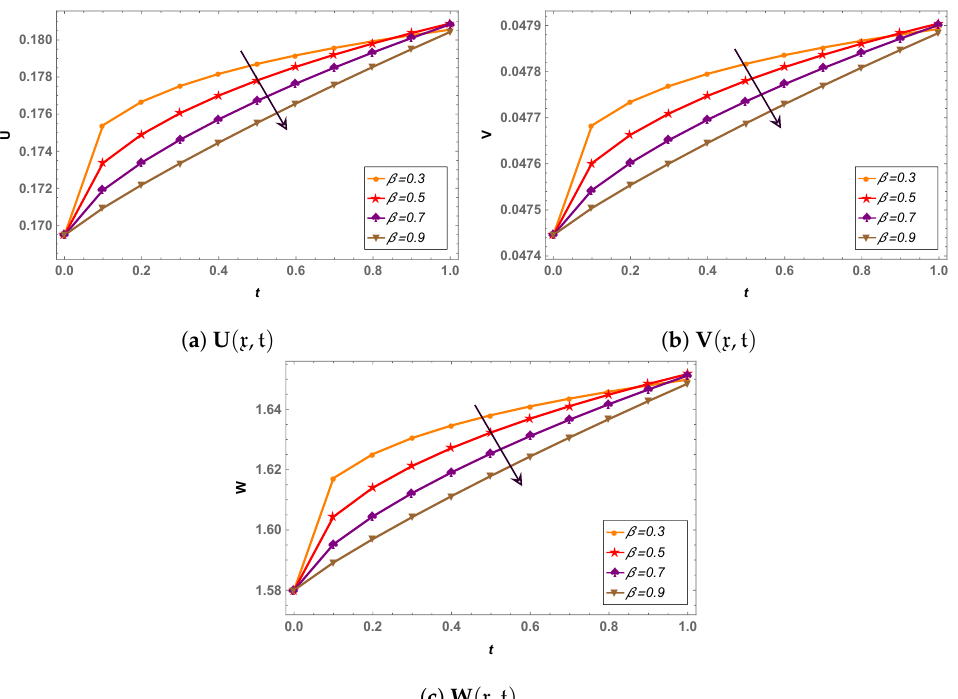
Figure 9. Two-dimensional (2D) plot of LHPM solutions at different β in Example 3 when α = 0.2, x = 5, c 0 = c 2 = 1 and p =